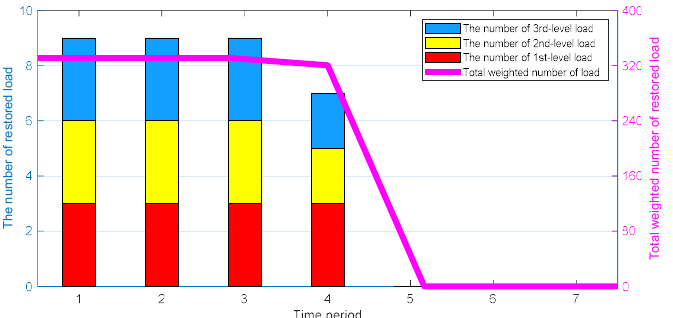
Figure 7. Critical load restoration of Strategy 1.